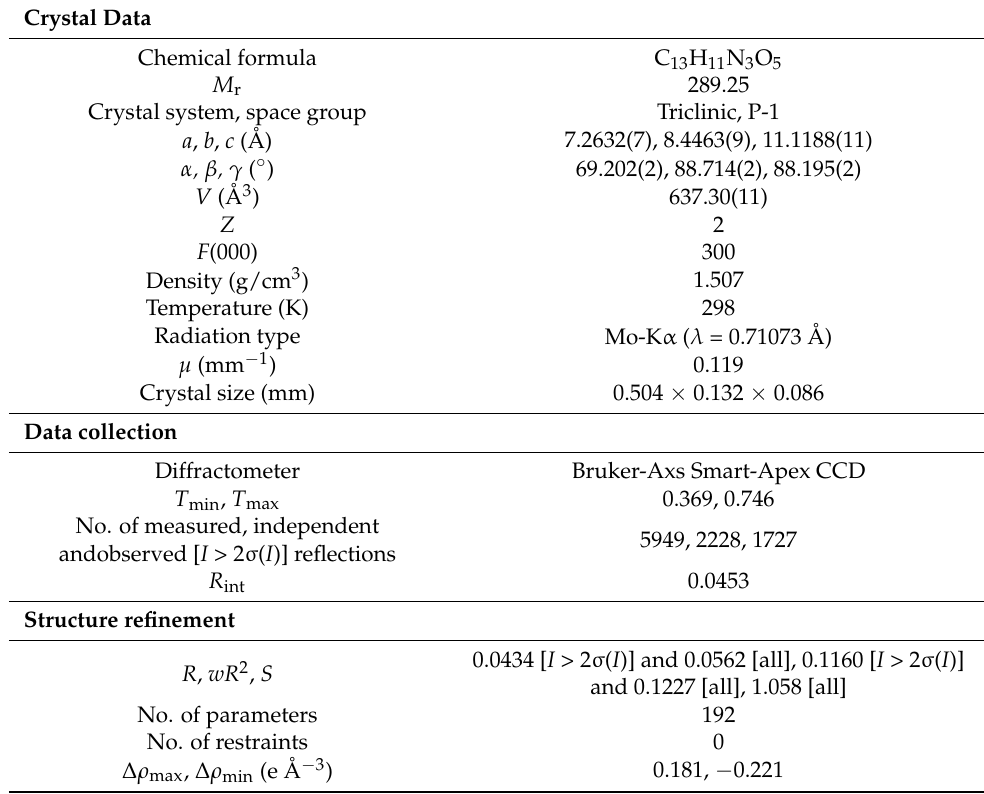
Table 1. Crystal data and structural parameters of compound 2 . Crystal